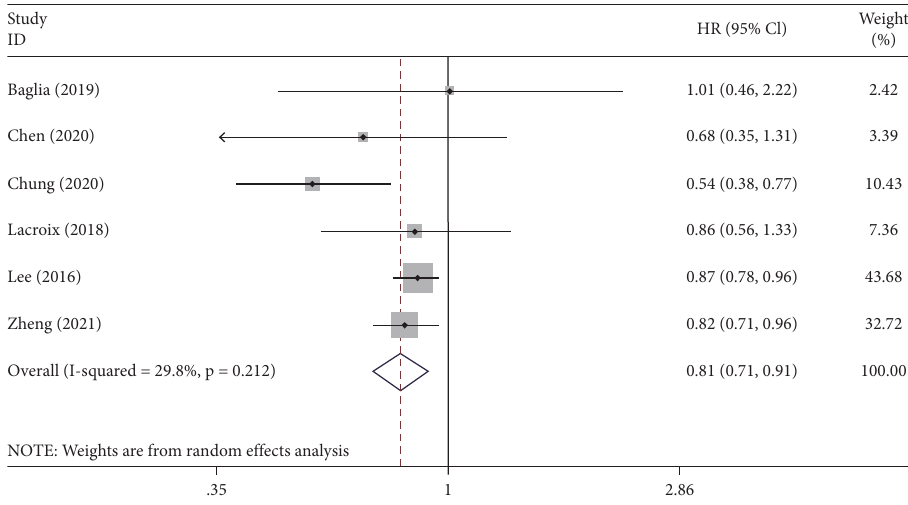
Figure 3: Forest plot of the cancer-specifc survival (CSS) of GC patients with T2DM after exposure to metformin ( p � 0.001).